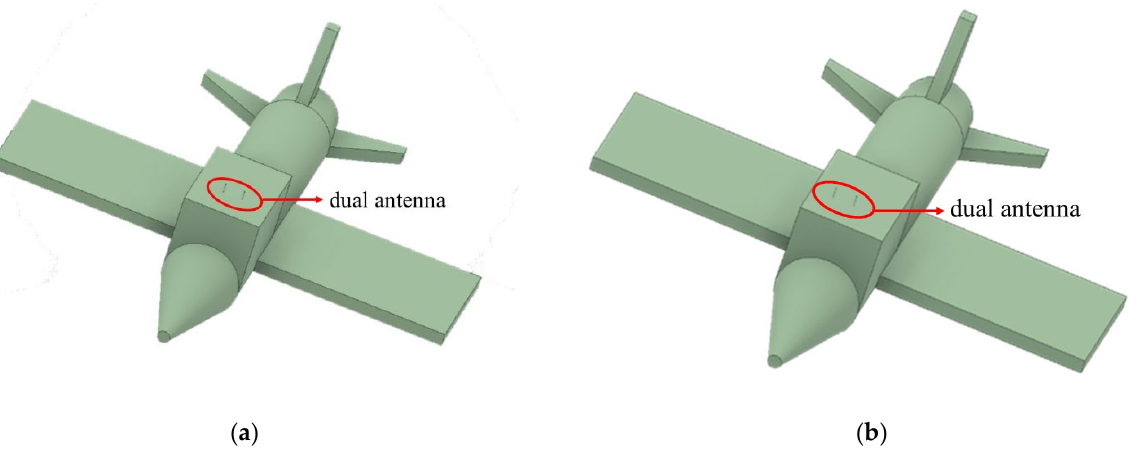
Figure 6. ( a ) 3D ‐ model of the antenna placed on both sides of the target; ( b ) 3D ‐ model of the echo cancellation antenna placed in the center of the target.